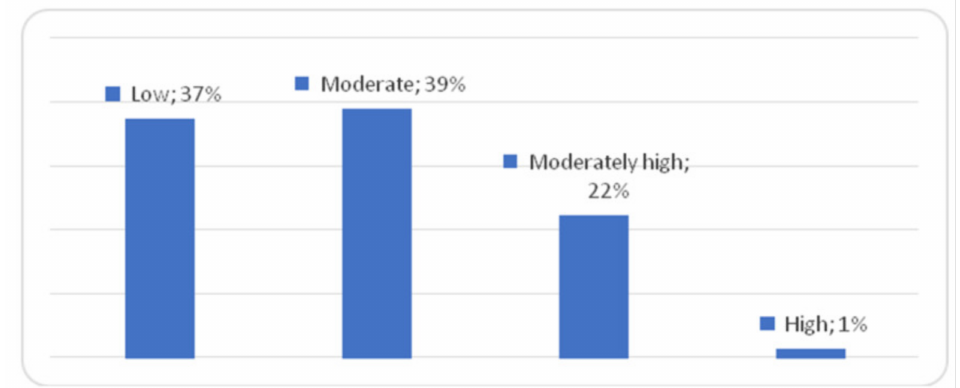
Figure 2. R-UCLA scores in the study population of women.